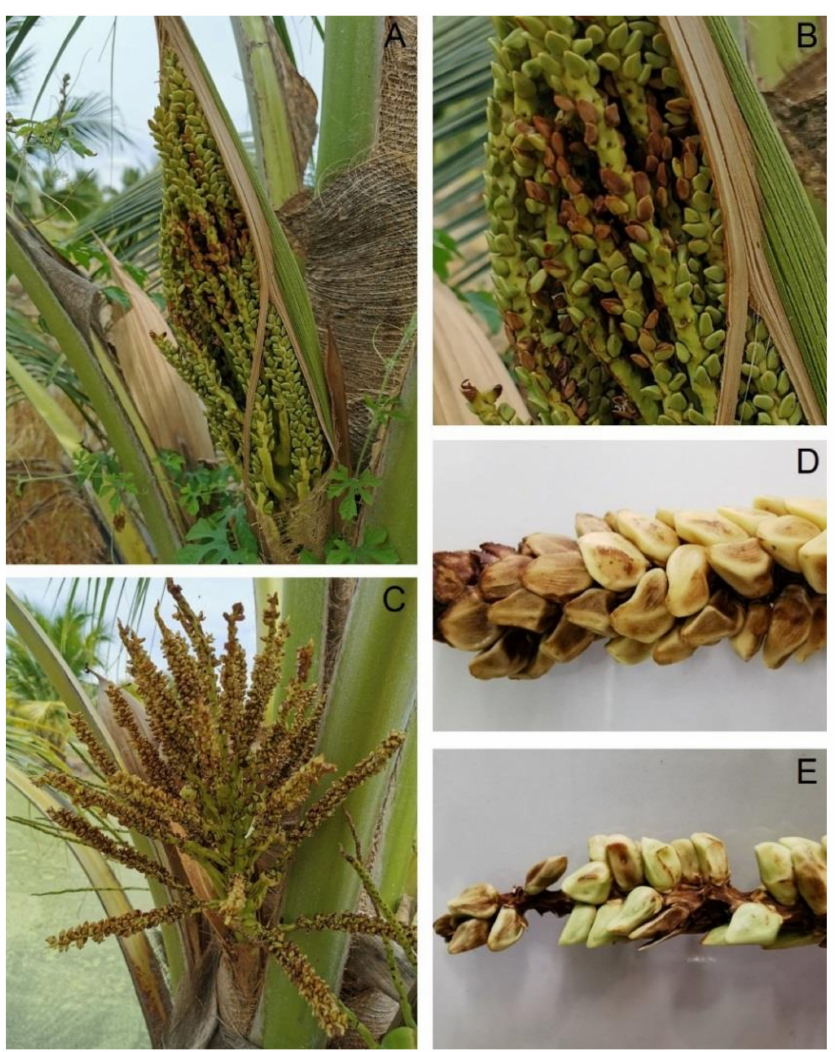
Figure 1. Dirty panicle disease observed on coconuts in KU-BEDO Coconut BioBank: Discoloration of male flowers ( A ) and zoomed-in view of infected flowers ( B ), flower drop ( C ), and infected panicles ( D , E